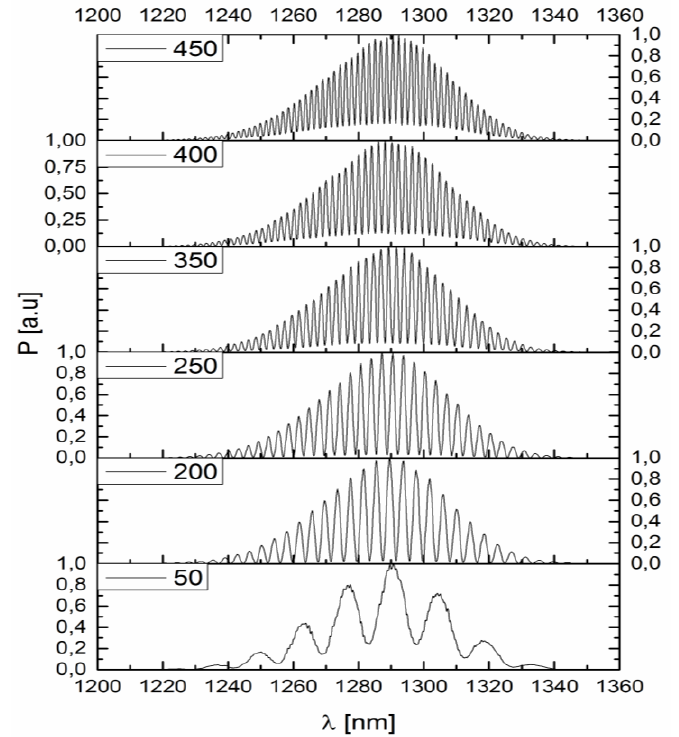
Figure 3. The spectrum of the measured optical signal for the Fabry-Perot cavity